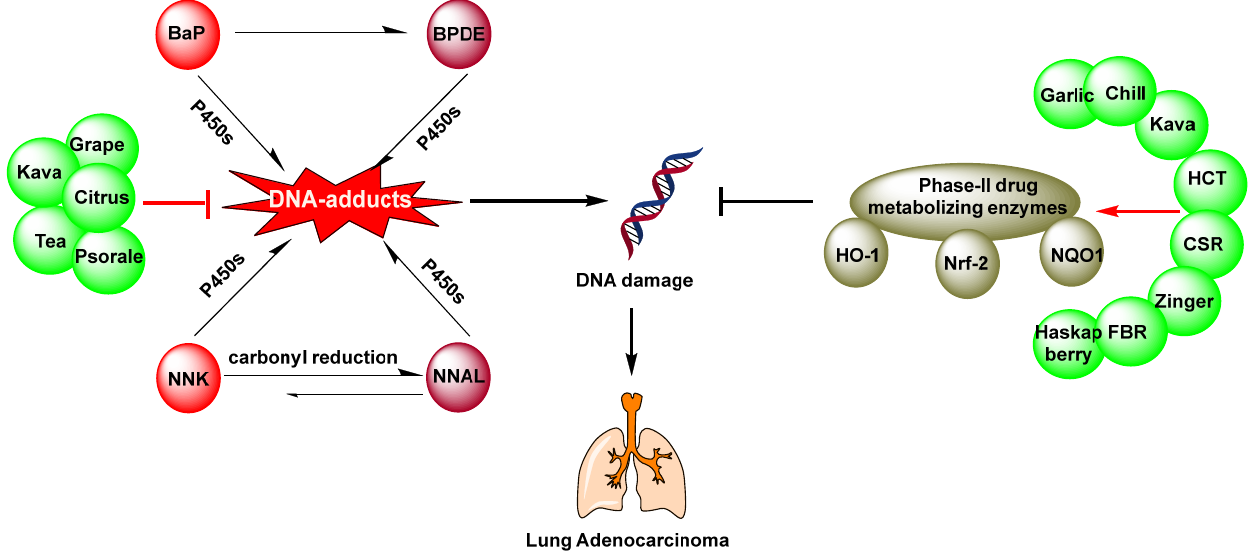
Figure 2. The mechanism of phytochemical prevention of tobacco-induced lung cancer.